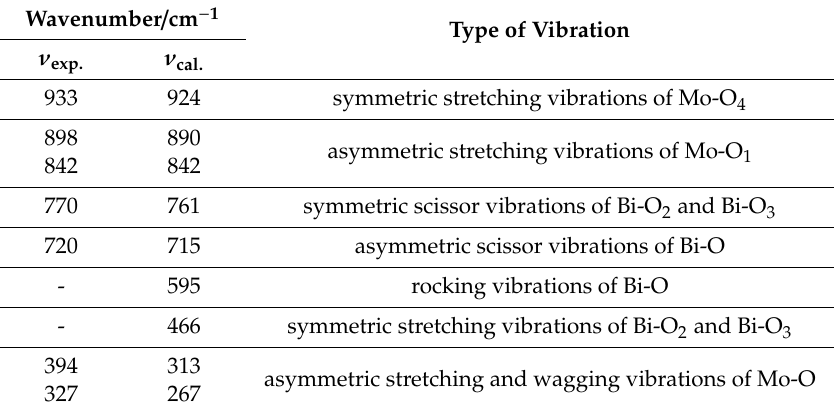
Table 3. The attribution of major vibrational modes in the melt of KBi(MoO 4 ) 2